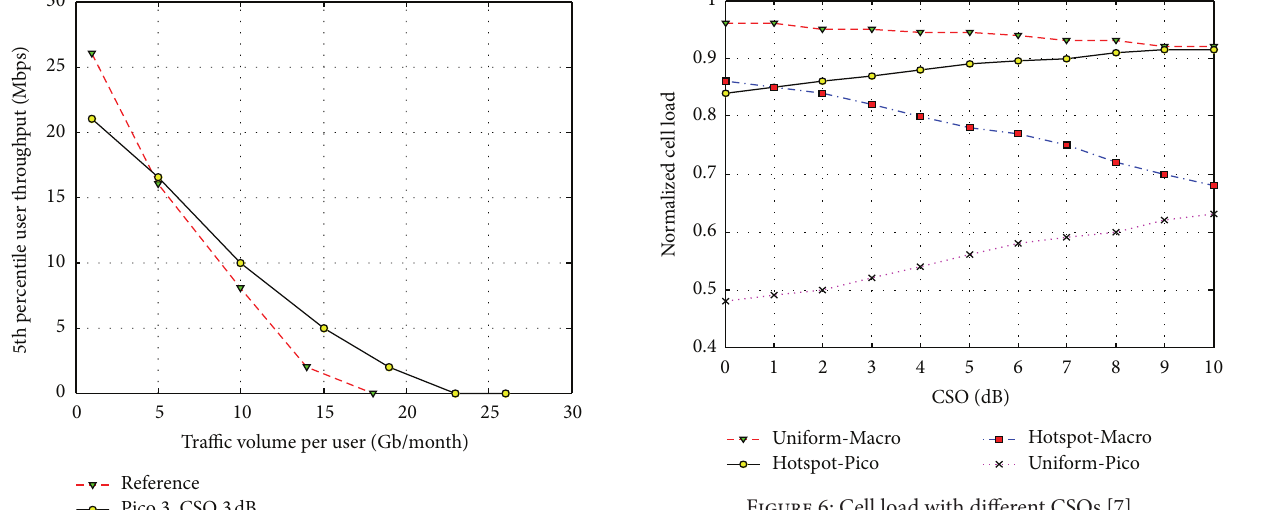
Figure 6: Cell load with different CSOs